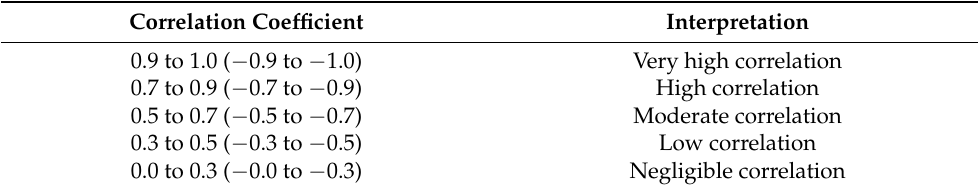
Table 5. Interpretation of Pearson correlation coefficients